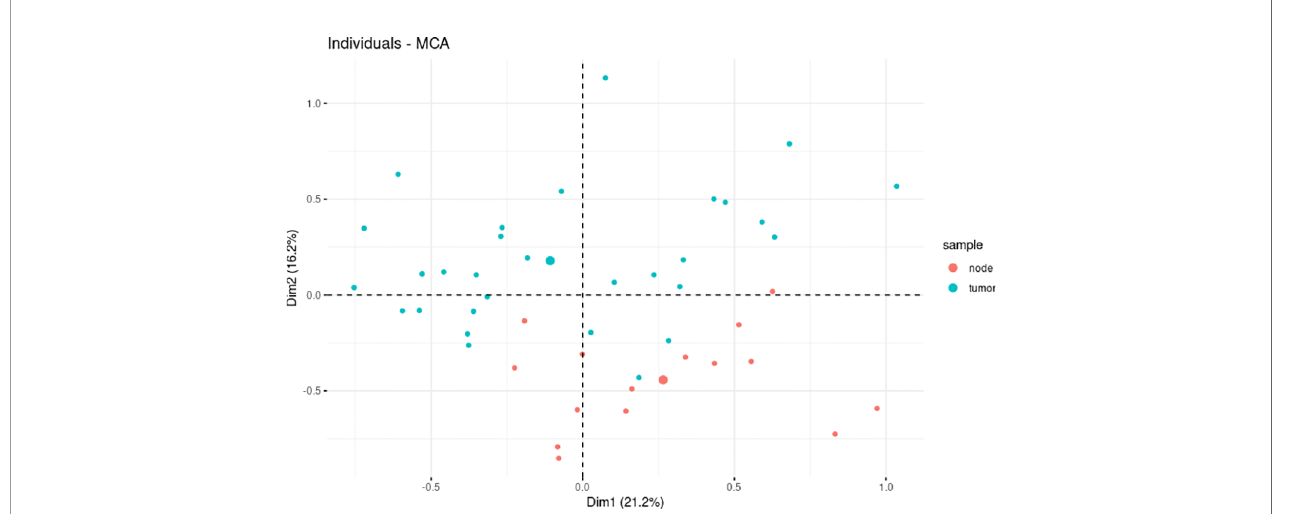
FIGURE 2 | The multiple correspondence analysis (MCA) revealed divergent levels of estrogen receptor (ER), progesterone receptor (PR), HER2, Ki-67, Bcl-2, cyclin D1, E-cadherin, GCDFP-15, Snail+Slug, PD-L1, and PRL-3 expression between primary tumors (PTs) (n = 37) and synchronous axillary lymph node (ALN) metastases (n =